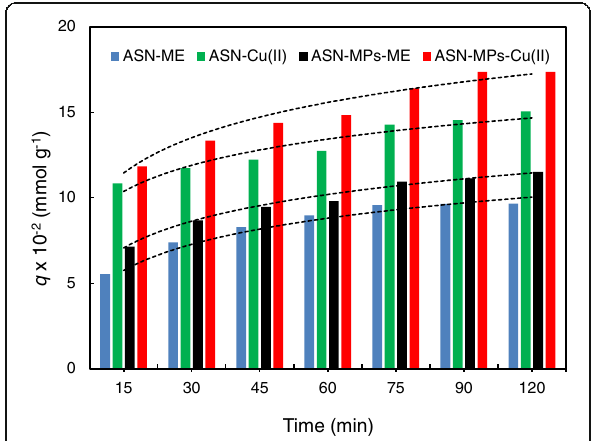
Fig. 6 The relationship between interaction time and the amount of ME and Cu(II) cations adsorbed on ASN and